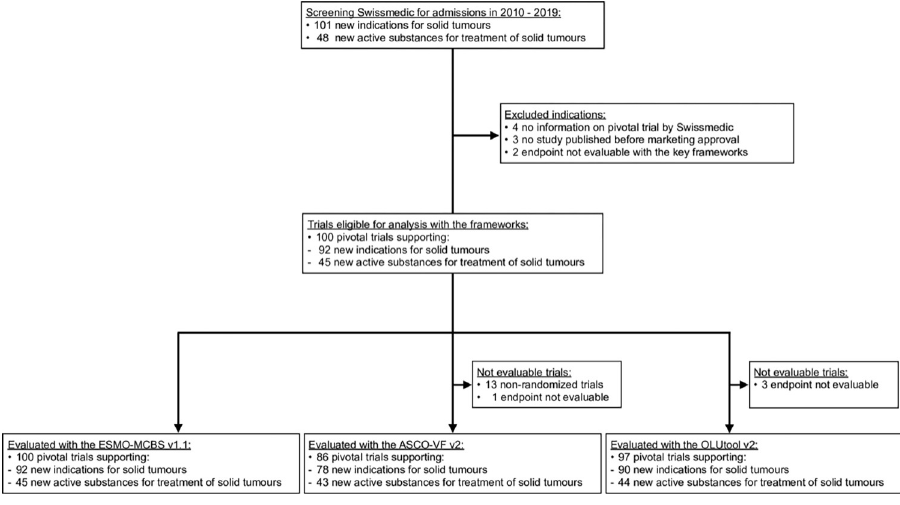
Fig 1. Identification of new active substances, indications for solid tumours and their supporting pivotal trials published between January 2010 and December 2019 which showed an endpoint evaluable with the ESMO-MCBS v1.1, the ASCO-VF v2 and the OLUtool